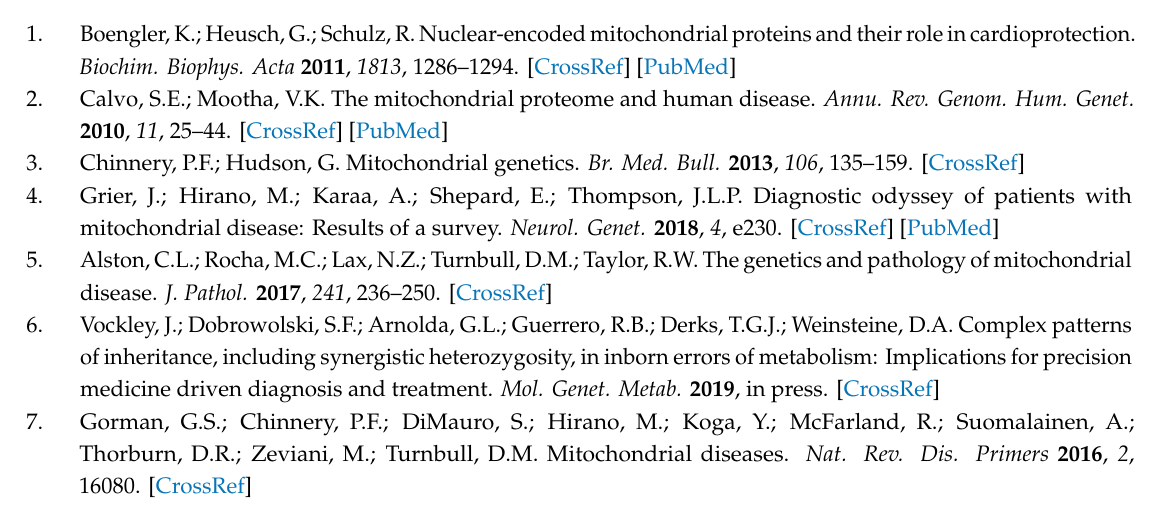
missing value estimation. Both rows and columns are clustered using correlation distance and average linkage. Table S1: Retrospective clinical diagnostic prediction scoring of genetically confirmed PMD patients. A score of ≥ 2 indicates the likeliness of a PMD, which is used clinically to initiate follow up of biochemical and genetic testing. Abbreviations: CC, corpus callosum; CSF: cerebrospinal fluid; EMG, electromyogram; FTT, failure to thrive; GI, gastrointestinal; MRS, magnetic resonance spectroscopy; WM: white